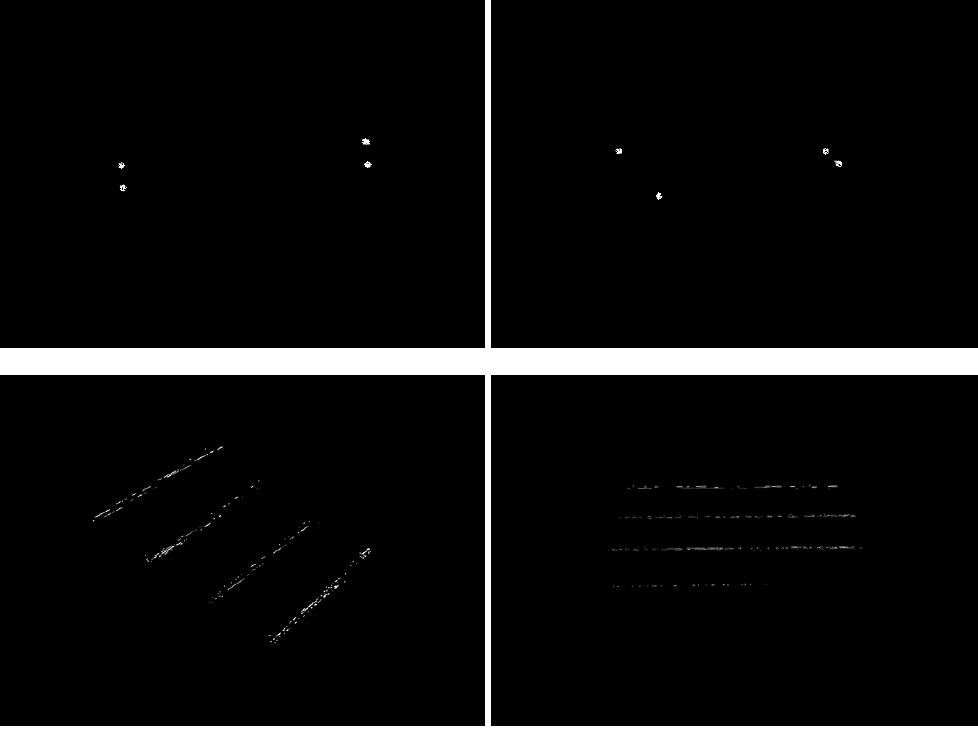
Figure 7. Images resulting from the projection step. Both top figures are clusters from the detection of doers and both bottom figures are from